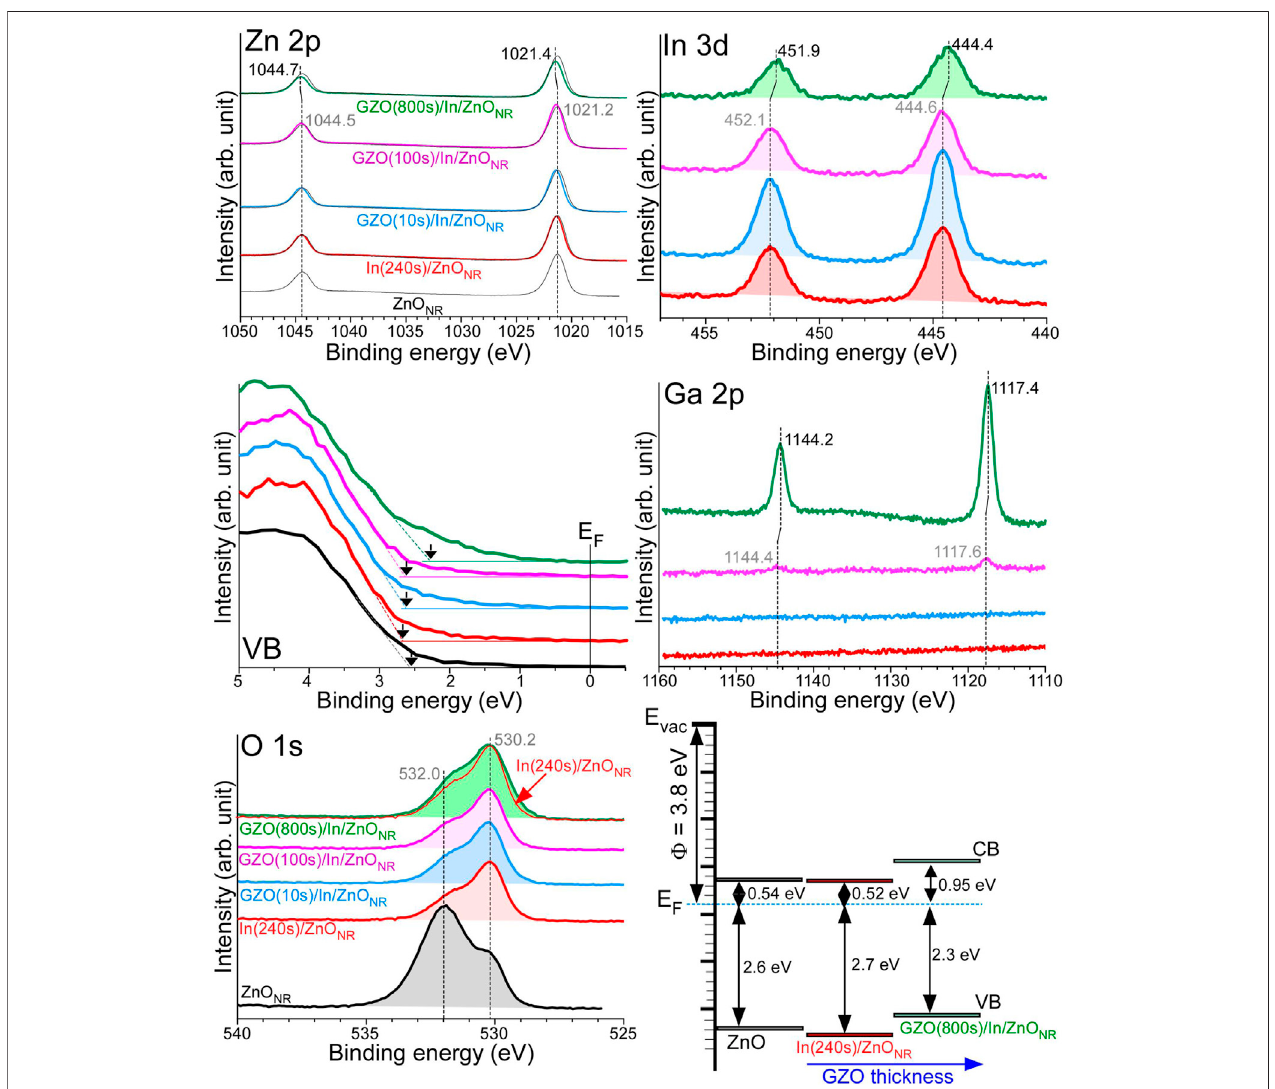
FIGURE 6 | Zn 2p, In 3d, VB, Ga 2p, and O 1s XPS pro fi les for ZnO NR , In(240s)/ZnO NR , GZO/In(240s)/ZnO NR with GZO thicknesses of 10, 100, and 800 s. The interfacial energy level alignments for ZnO NR , In(240s)/ZnO NR , and GZO(800s)/In(240s)/ZnO NR samples.